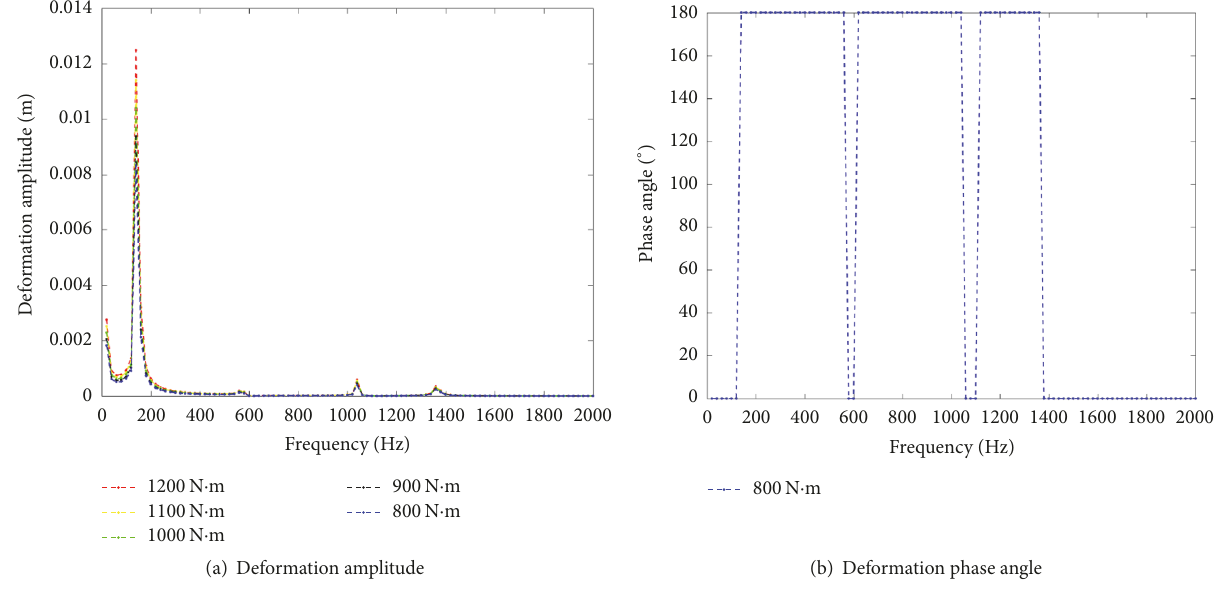
Figure 5: Influence of torque on harmonic response of spiral bevel